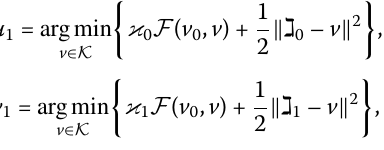
Algorithm 2 Explicit Popov’s subgradient method using the non-monotone stepsize